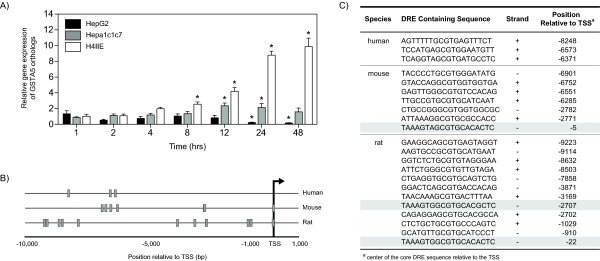
Comparative analysis of GSTA5 orthologs. (A) QRTPCR verification of the divergent expression of GSTA5 orthologs in human HepG2, mouse Hepa1c1c7 and rat H4IIE cell lines. Fold changes were calculated relative to time-matched vehicle controls. Error bars represent the standard error of measurement for the average fold change and the asterisk (*) indicates p < 0.05. (B) Gene regulatory regions (-10,000 to 1,000 bp relative to the transcription start site [TSS]) were computationally searched for the 5 bp DRE core (GCGTC) and indicated by the grey boxes. Each core was extended by the flanking 7 bp, and the resulting 19 bp sequence (C) was compared to a consensus DRE sequence using a position weight matrix developed from bona fide functional DREs. The shaded rows in (C) indicate the highly similar mouse and rat DRE sequences (Euclidean ≤ 3.0).